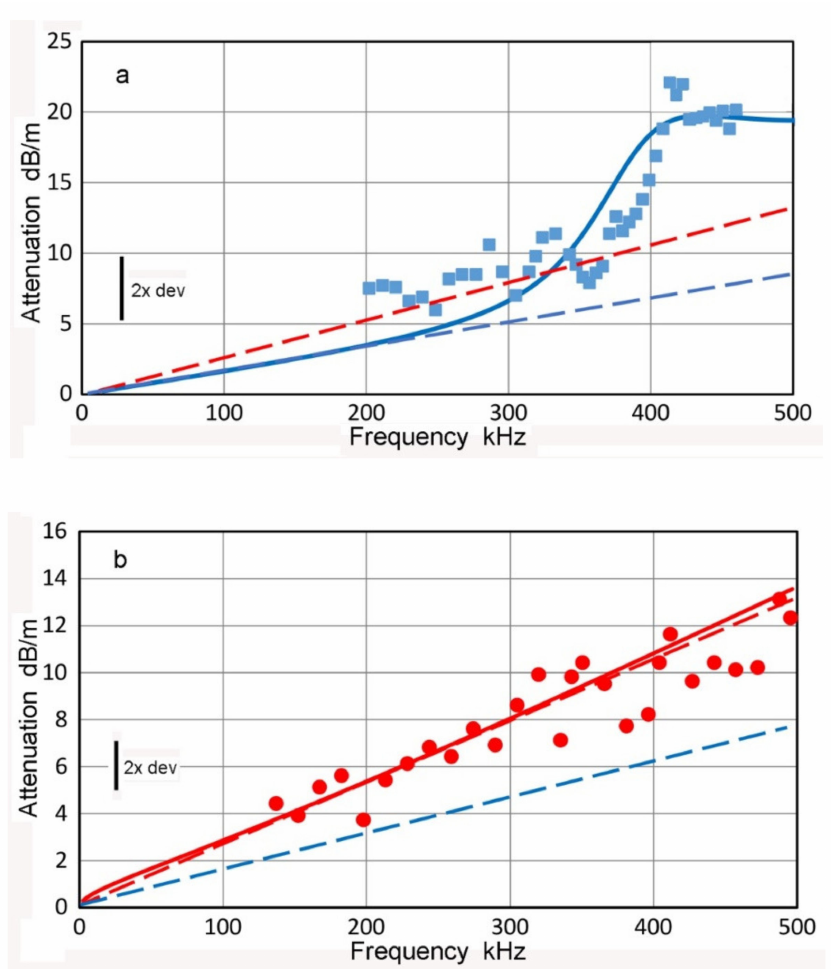
Figure 7. ( a ) α –S o values for Al 1100 plate of 6.4-mm thickness plotted in blue squares used Olympus V101 as Tx and KRN-BB-PC as Rx. Calculated α –S o (solid blue curve), α L and α T (blue and red dashed lines) are also plotted. Vertical bar shows 2 × dev. ( b ) α –A o values for Al 1100 sheet of 6.4-mm thickness plotted in red dot symbols, using short-pulse excited NDT C16 Tx at 60 ◦ incident angle and KRN-BB-PC Rx. Calculated α –A o (solid red curve), α L and α T (blue and red dashed lines) are also plotted. Vertical bar shows 2 ×